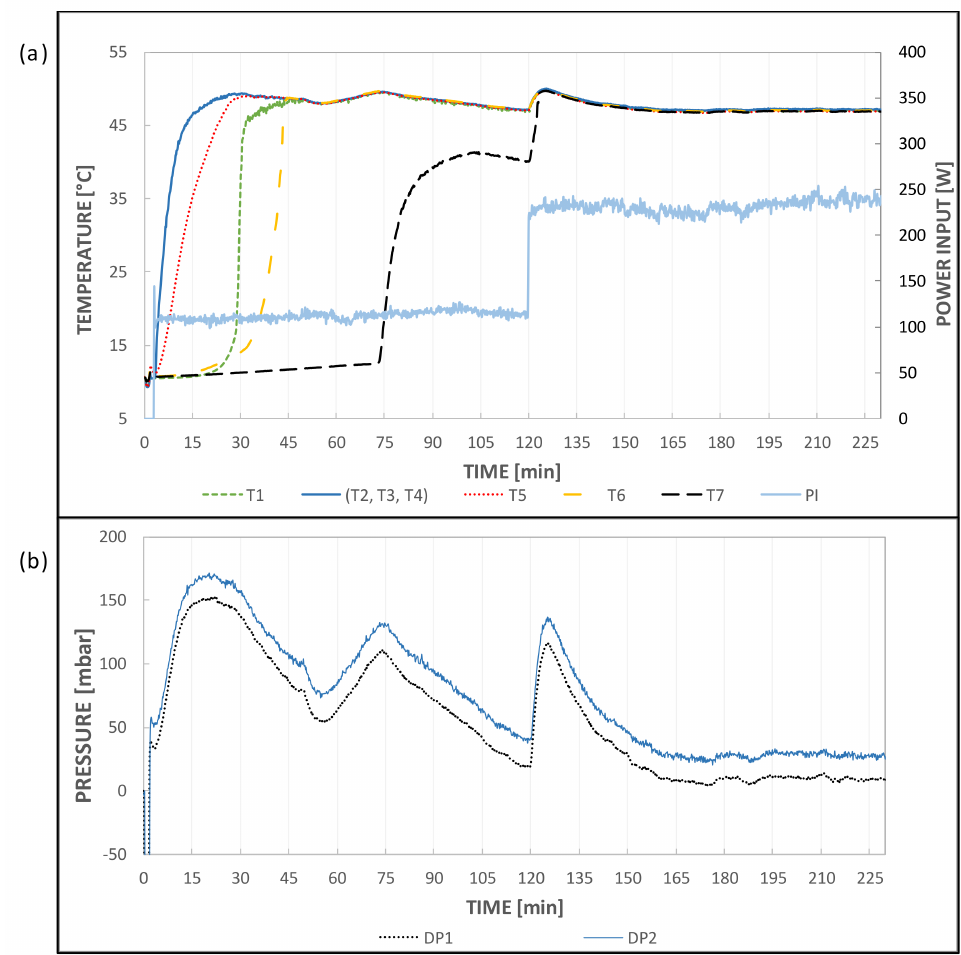
Figure 3. ( a ) Transient evolution of main temperatures and ( b ) pressures inside the CLTPT and their response to a power input